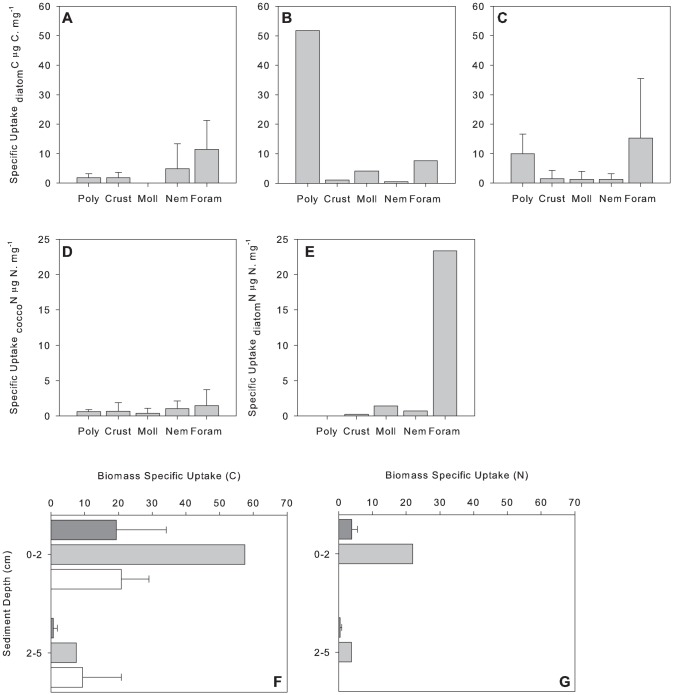
Mean biomass specific uptake µg C mg−1 or µg N mg−1 (±1 standard deviation) of (a) diatomC from Exp. 1 in June; (b) diatomC from Exp. 2 in June; (c) diatomC from September; (d) coccoN from Exp. 1; (e) diatomN from Exp. 2.Vertical distribution of biomass specific uptake of (f) phytoC and (g) phytoN. In plots f and g, dark grey bars represent incorporation from Exp. 1, light grey bars represent incorporation from Exp. 2 and white bars represent mean incorporation of tracer from September. Note the data presented from Exp. 2 in June represents total biomass specific uptake µg C mg−1 or µg N mg−1. Number of replicates in Exp. 1 = 3 and Exp. 2 = 1 and September  = 3.